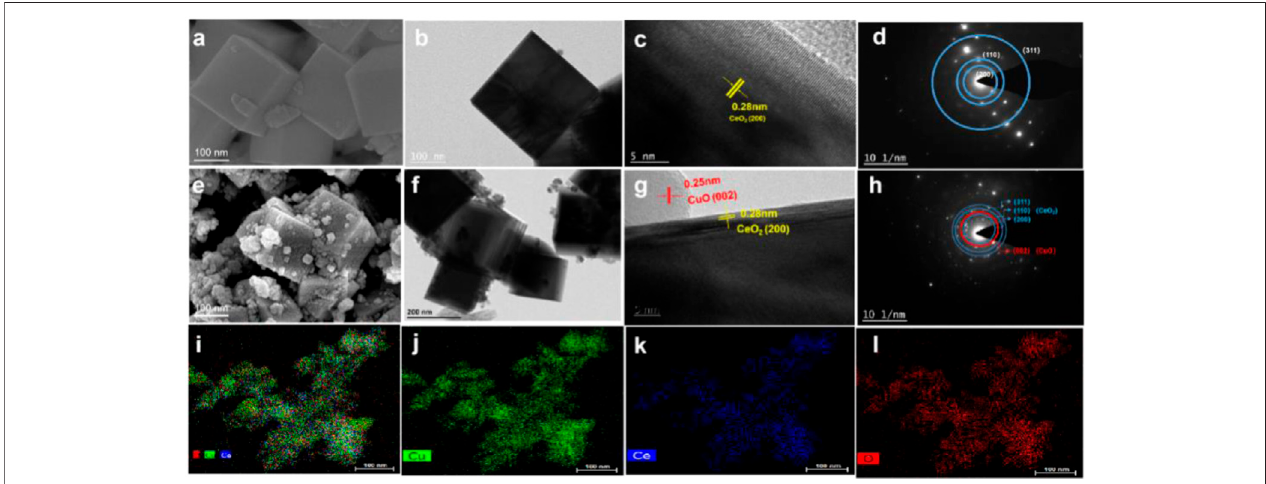
(B) TEM images of CeO (C) HRTEM images of CeO 2 ; 2 ;